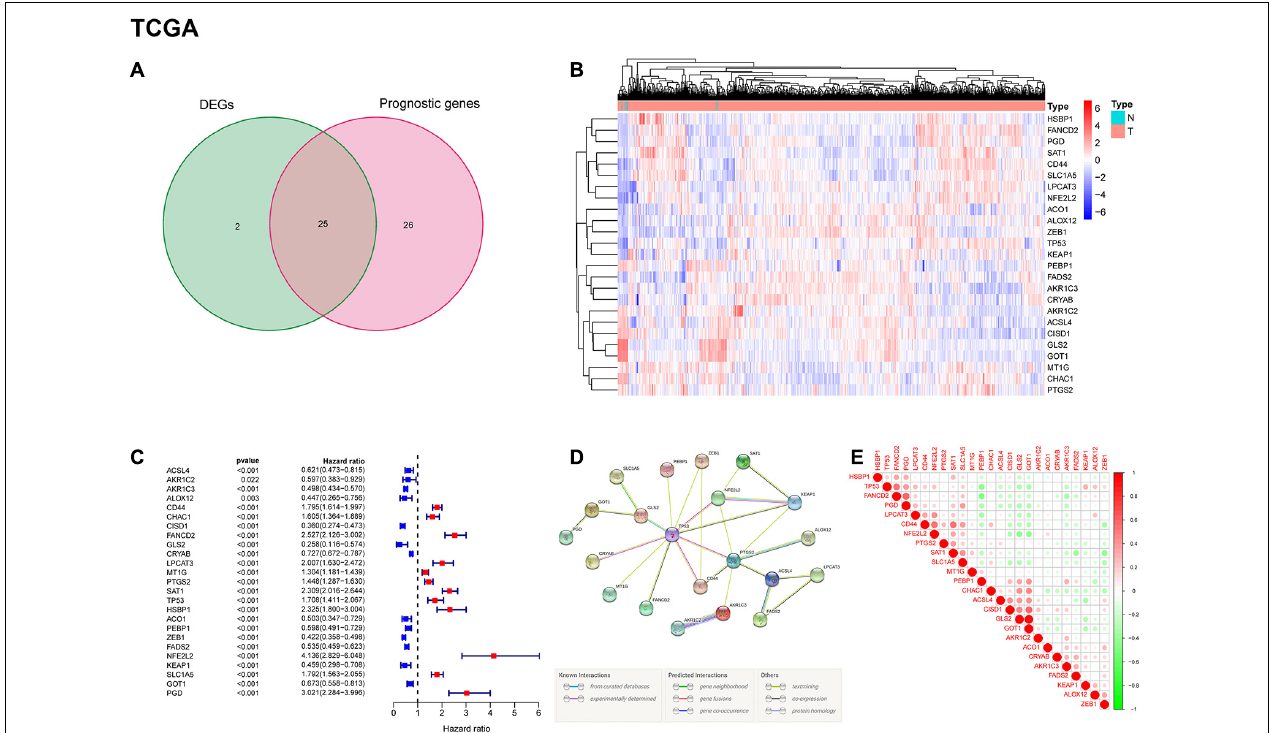
FIGURE 2 | Identification of prognostic ferroptosis-related DEGs in the TCGA cohort. (A) Venn diagram shows the differentially expressed genes between tumor and adjacent normal tissues of prognostic value. (B) Gene expression levels of DEGs in the TCGA dataset. Red indicates up-regulated genes; blue indicates down-regulated genes. (C) Results of univariate Cox regression analysis between candidate gene expression and OS. (D) PPI network among candidate genes indicates that TP53 and PTGS2 are the hub genes. (E) The correlation between candidate genes. Red represents positive correlation; green represents negative correlation.